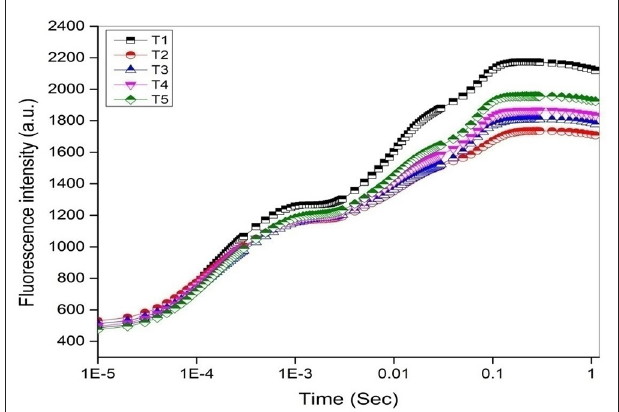
TABLE 3 | Parameters obtained from fluorescence transient curves measured on day 45 under different treatments on tomato plant. Treatments